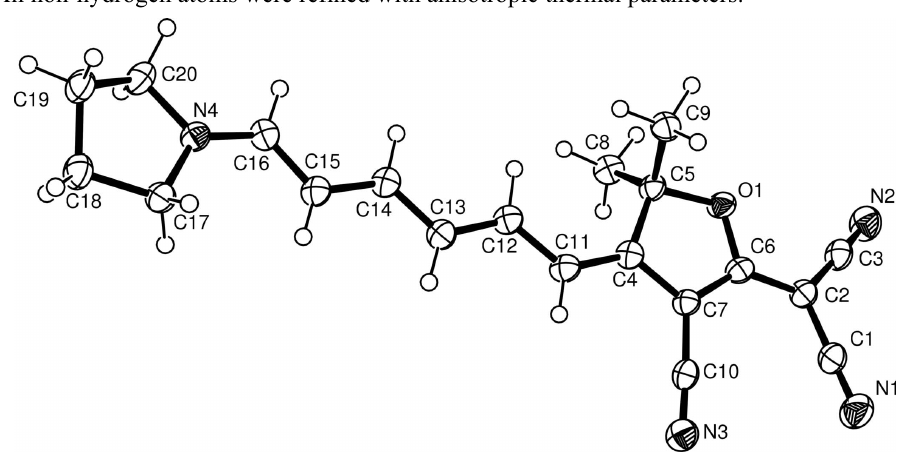
Molecular structure of the asymmetric unit (Farrugia, 1997); displacement ellipsoids are shown at the 50% probability